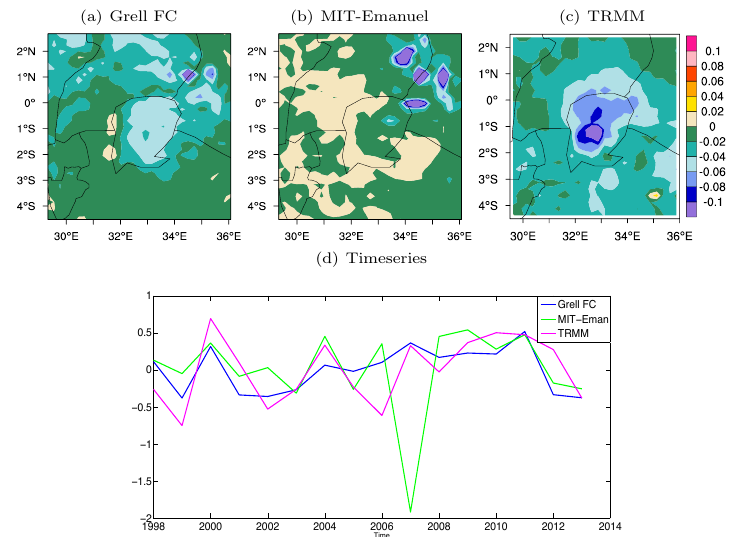
Figure 13. Spatial and temporal distribution for Long Rains EOF1 precipitation from models and observation ( a ) Grell FC, ( b ) MIT Emanuel, ( c ) TRMM, and ( d ) timeseries plot for EOF1 over the Lake Victoria Basin.